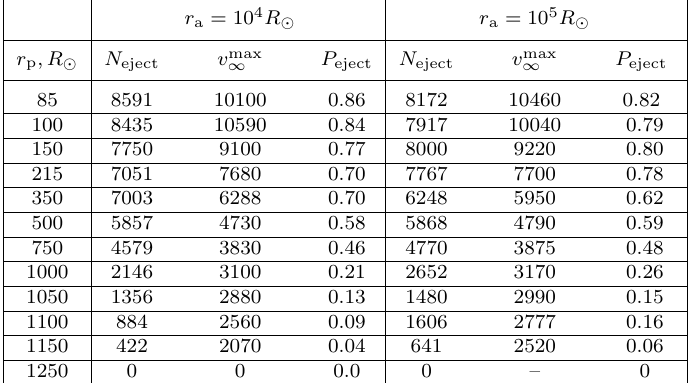
Table 1. Probabilities and maximal velocities (km s − 1 ) of HVS ejection estimated on the statistics of 10 4 orbital realizations of the CBS depending on pericentric distance and for the fixed distance 10 4 R ⊙ in the